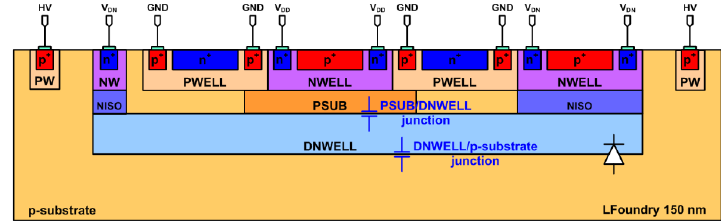
Figure 5. Diagram of the RD50-MPW1 depleted CMOS sensor pixel